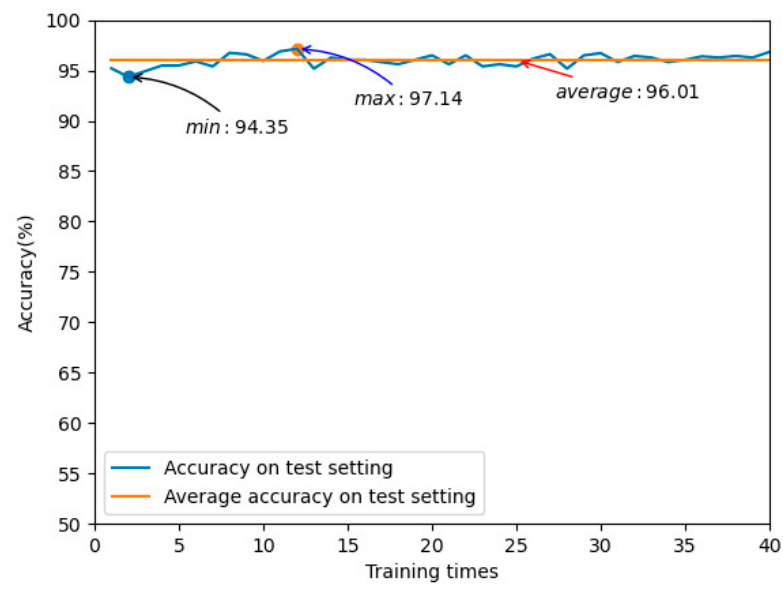
Figure 12. Multi-training results.